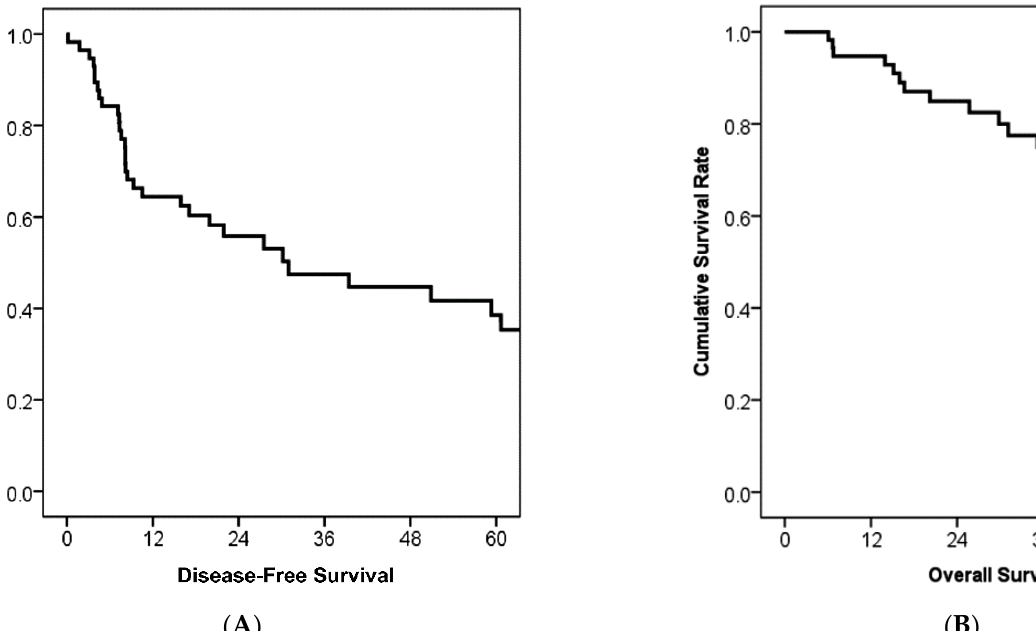
Figure 1. Kaplan–Meier survival curves of disease-free survival and overall survival ( n = 59). ( A ) The median disease-free survival was 30.9 months and the 5-year disease-free survival rate was 38.5%. ( B ) The median overall survival was 78.8 months and the 5-year survival rate was 57.4%.